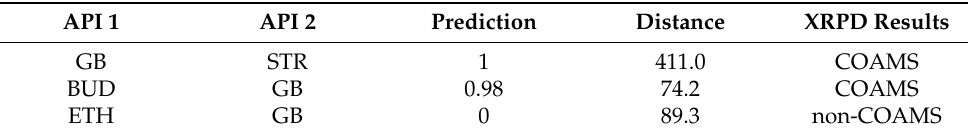
Table 5. List of API-API combinations for experimental model validation, the prediction, distance and XRPD